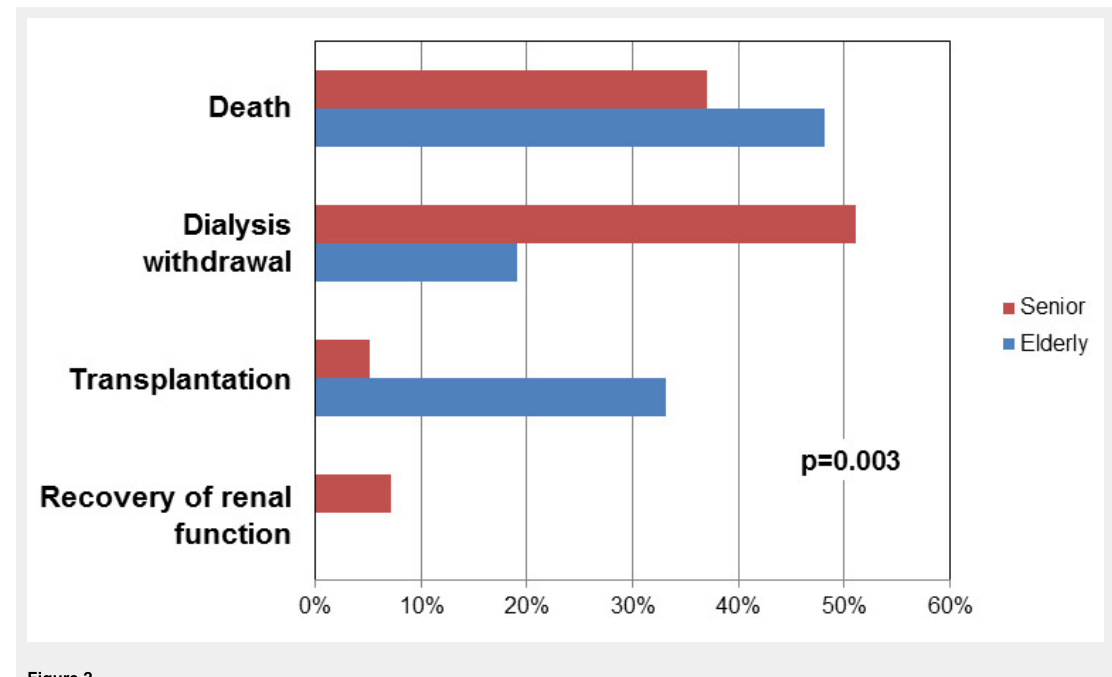
Figure 2 Reasons for cessation of haemodialysis